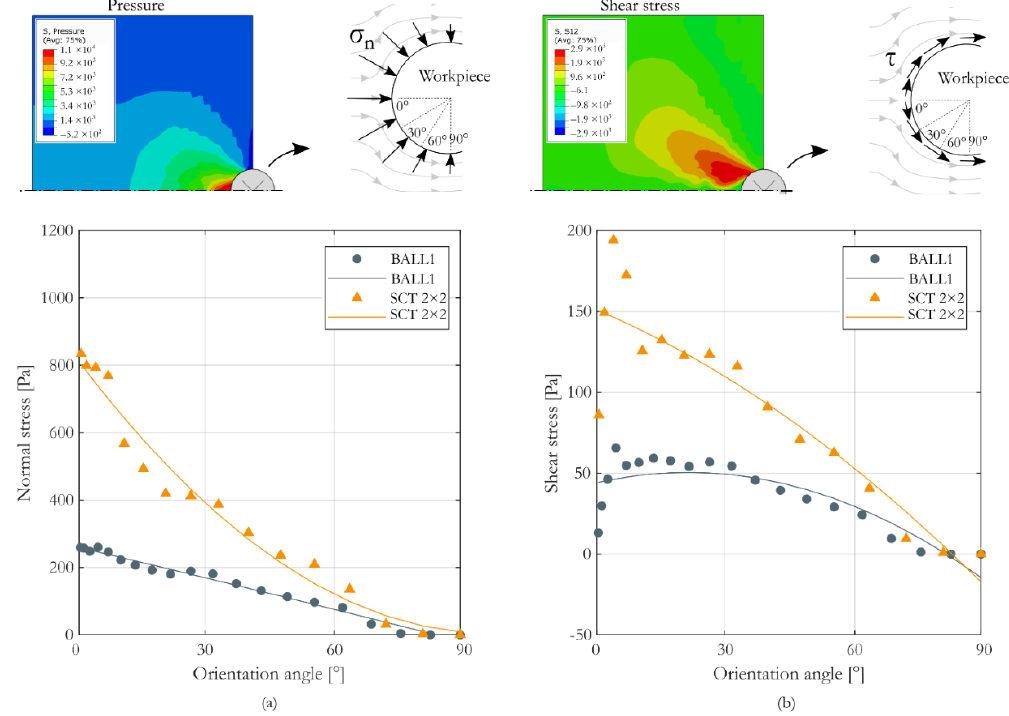
Figure 8. ( a ) Normal stress and ( b ) shear stress depending on the surface orientation angle for both abrasive